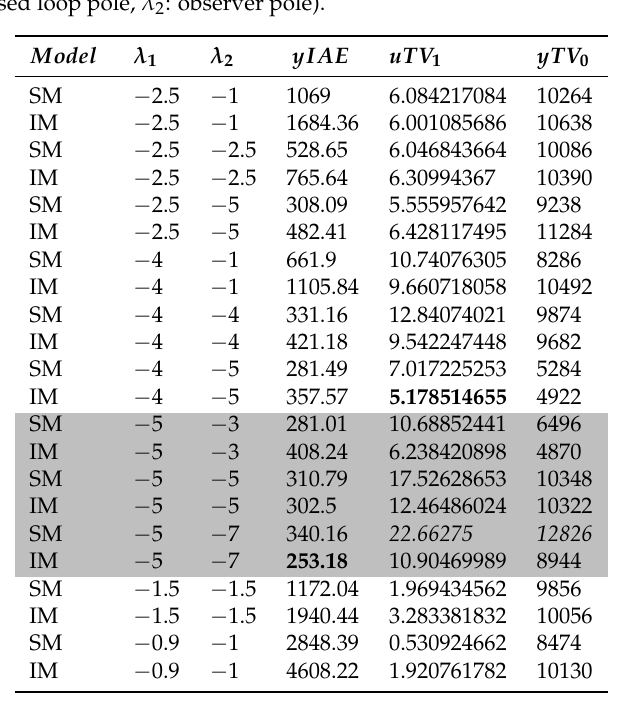
Table 2. Performance measures—Disturbance step (SM: static model (10), IM: integrating model (11), λ 1 : P controller closed loop pole, λ 2 : observer